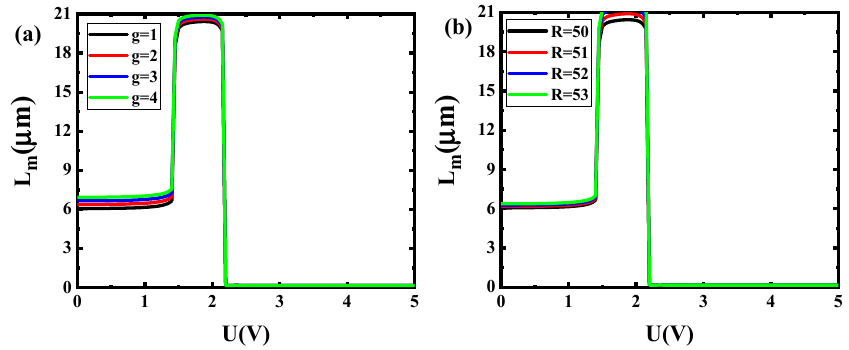
Figure 11. Dependence of L m on external voltage in different fabrication error tolerance for the proposed modulator GESMBOSN: ( a ) g ( b ) R.